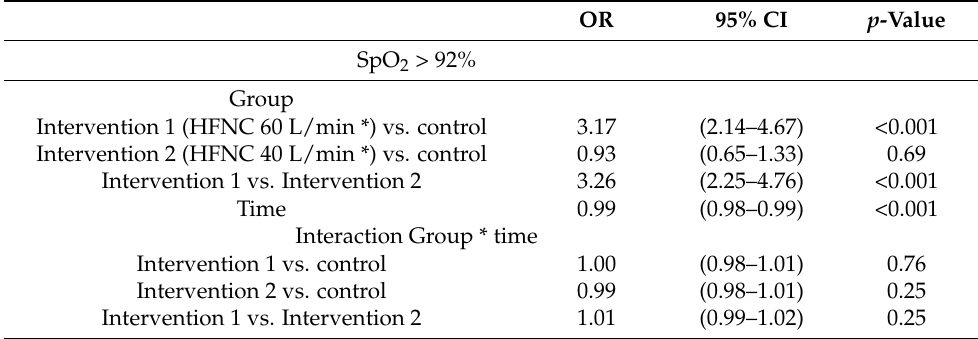
Table 2. Results of logistic regression analyses for levels of SpO 2 > 92 and respiratory rate within 12 to 20 breaths/min, without escalation of support above its initial